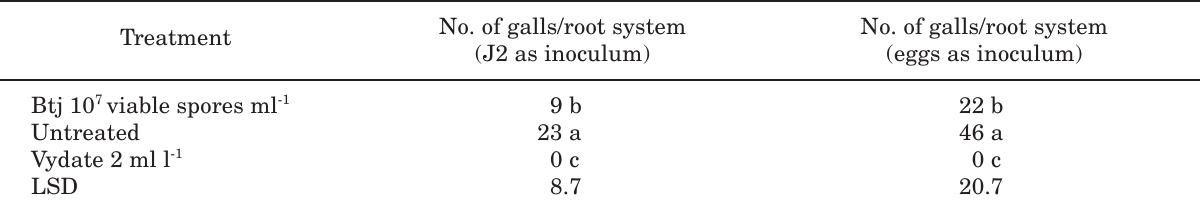
Table 1. Effect of Bacillus thuringiensis jordanica (H71) on Meloidogyne javanica and its damage to tomato in a glasshouse pot experiment a .